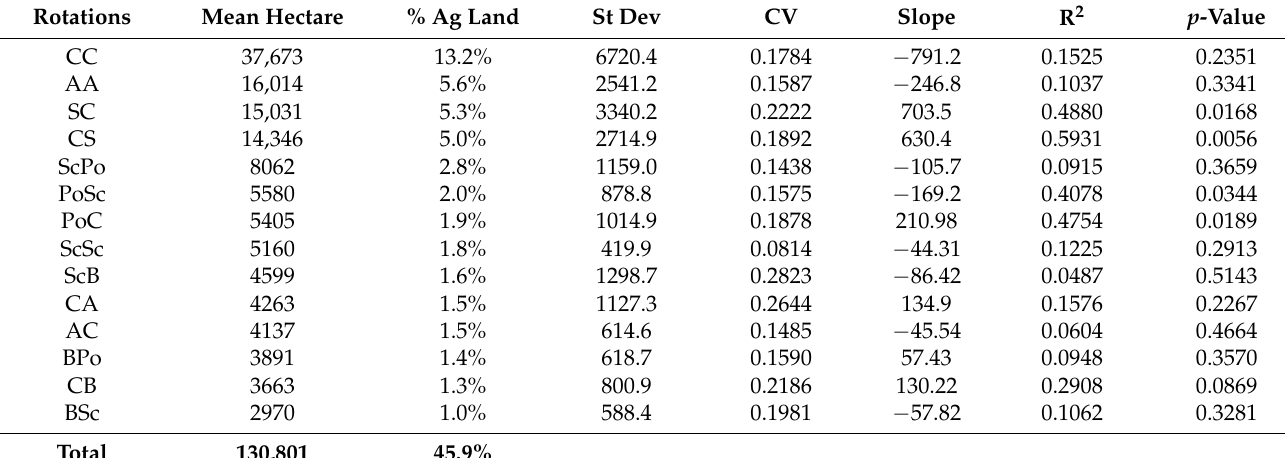
Table 3. Most common two-year rotations and their respective average hectare totals and percent coverage of agricultural land in the WCS. Standard deviation indicates the extent of deviation from the mean each rotation has; the CV is the coefficient of variation of annual average variability across all years; the slope, R 2 , and p -value are from linear regression and indicate the change in hectares planted during the study period, how well this change represents the data, and whether this change is significant. The following abbreviations correspond to the crop grown; C = corn, A = alfalfa, S = soybean, Sc = sweet corn, Po = potato, B =